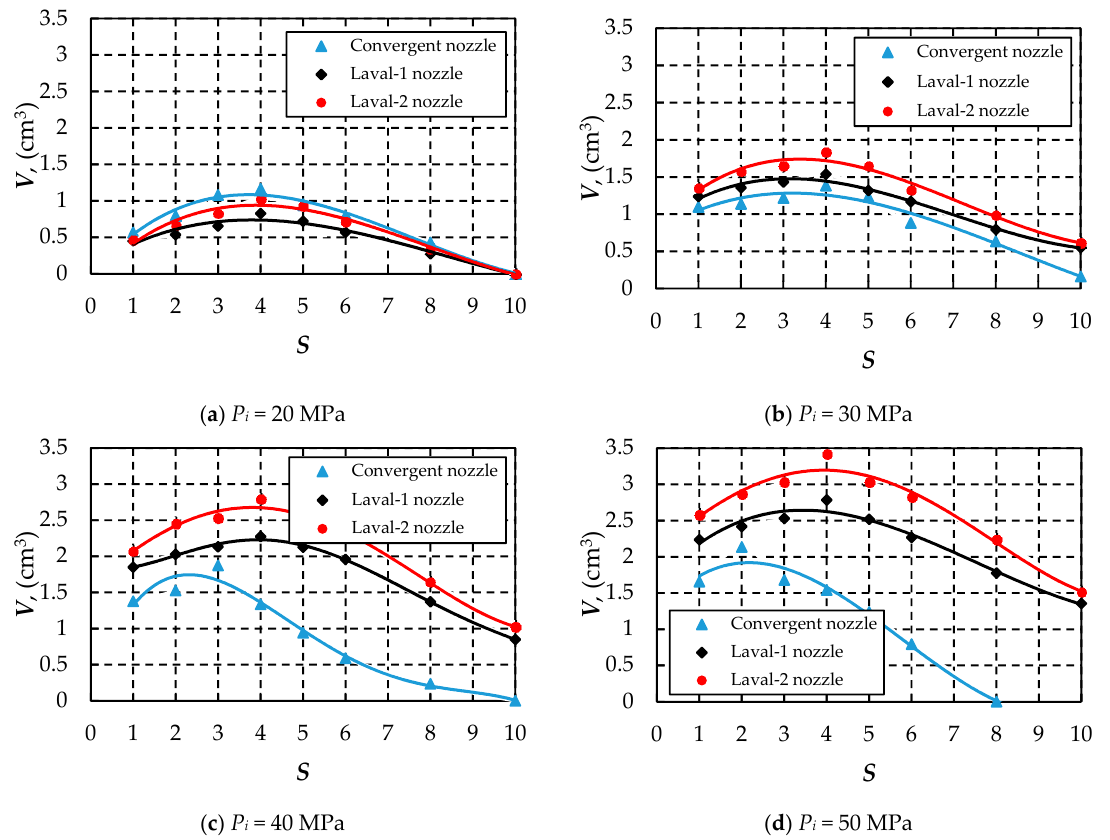
Figure 6. Effect of nozzle configuration on rock erosion volume of the supercritical carbon dioxide (SC-CO 2 ) jet under different inlet pressures.